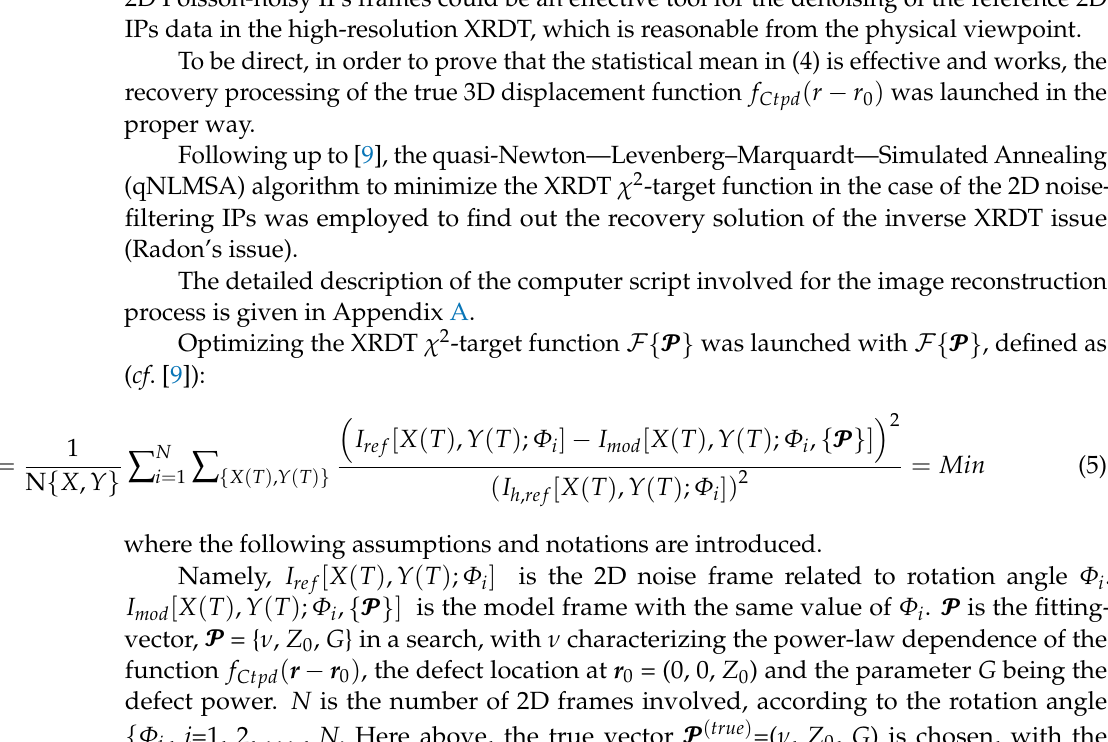
Figure 3. The 2D IPs: no- noise level (left), 4% -noise level (middle) and de-noised (right). The number of non-averaged IPs data frames is equal to 100. The sample rotation angles Φ are equal to {−20°, 0°, 20°}, respectively.